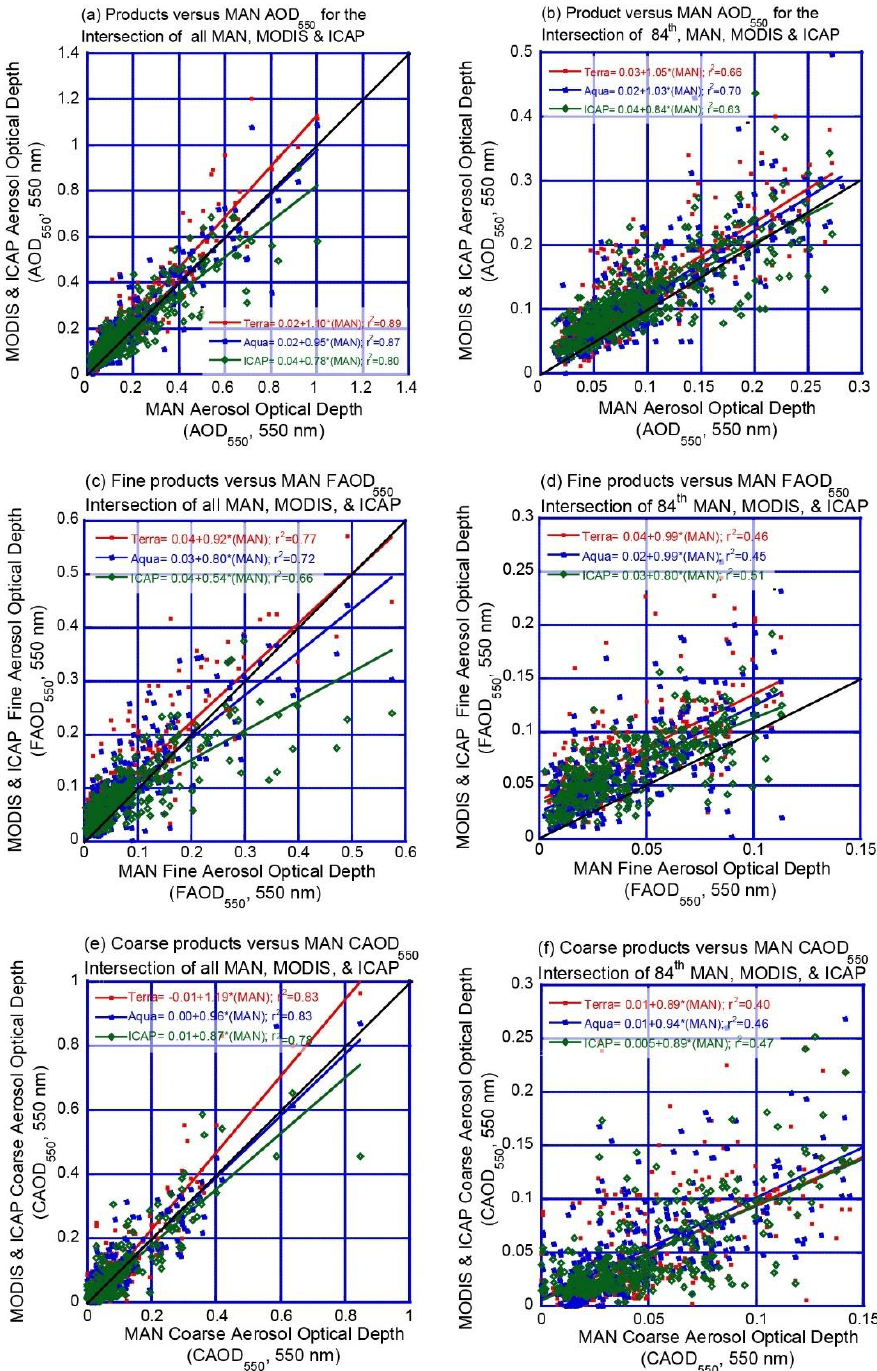
Figure 7. ( a , c , e ) Scatter plots of MODIS and ICAP consensus mean total, fine, and coarse AOD 550 products to corresponding MAN data (within 1° and +/ −2 h), only when both Terra and Aqua match to the same MAN data point. Therefore, those data points where and when there is a union of all sensors and the ICAP consensus. The left column includes all data points; the right trims the uppermost 16% to provide more focus on lower AOD values. ( b , d , f ), same as ( a , c , e ), respectively, but for the lowest 84th values.